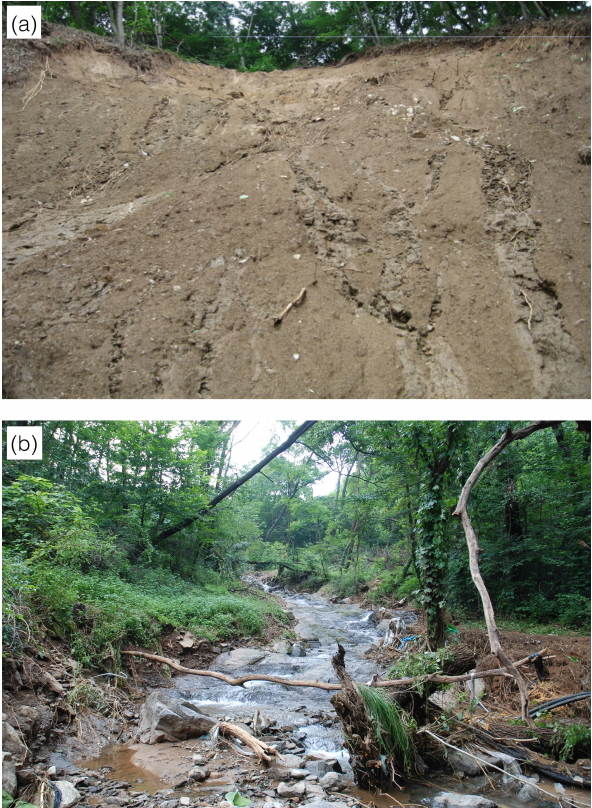
Figure 4. Landslides in Site A. (a) Overall trace of the landslide at Raemian A.P.T. area, looking southeast. Components of debris flows proposed by VanDine (1996) are identified. (b) Eroded collu- vial layers observed at 320m from the initiation zone.